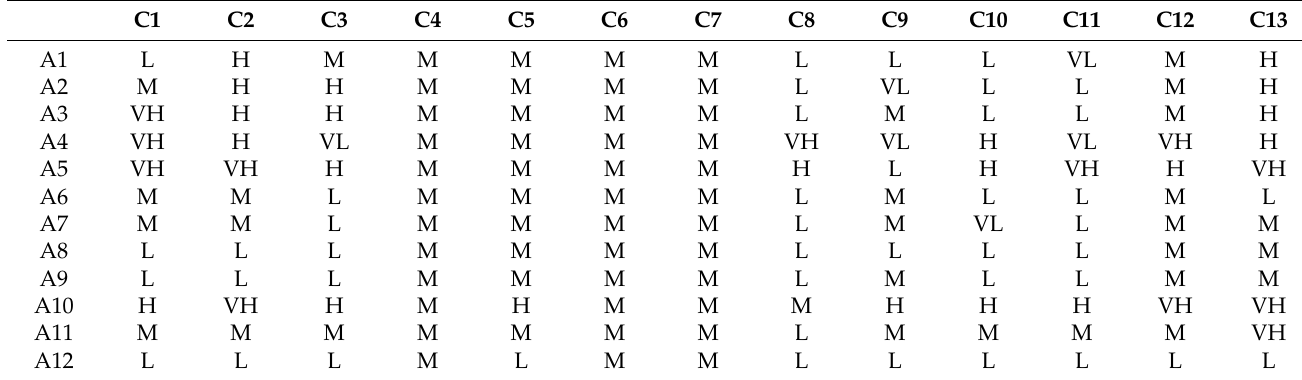
Tables A3–A6 show the decision makers’ alternatives ratings against all the criteria Table A3. Decision maker 1 (cid:48) s linguistic assessment.